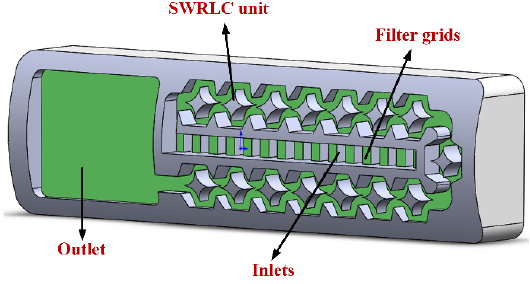
Figure 2. 3D physical model of SWRLC emitter. Table 1. Key design parameters of SWRLC emitter.